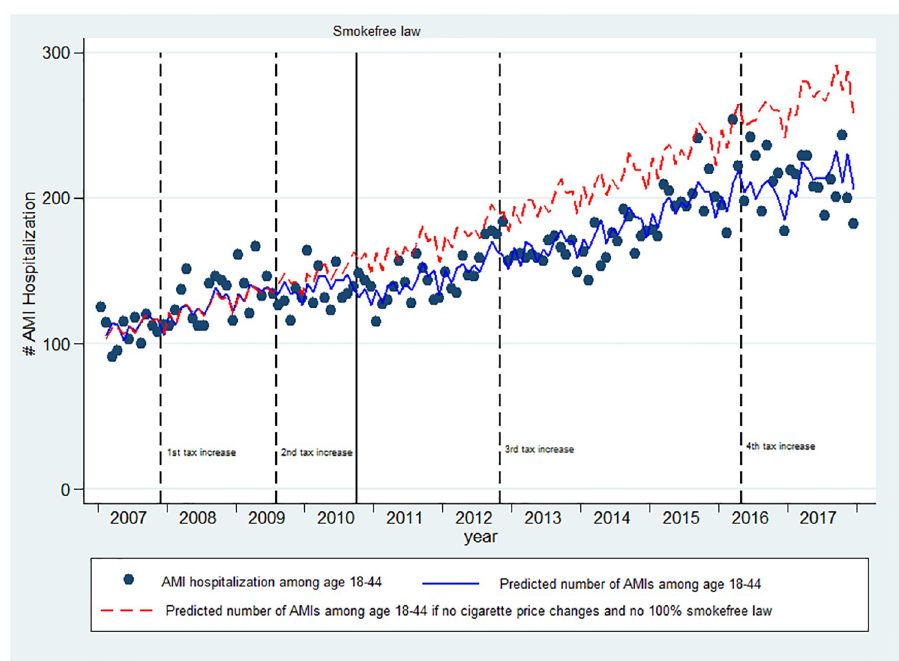
Fig 2. Association of increase in cigarette price and smokefree laws on AMI among young adults. The number of AMI hospitalizations among age 18–44 dropped significantly after the increase in cigarette price and the implementation of 100% smokefree law between October 2006 and September 2017. Solid lines (blue) on the plots are the predicted number of AMI hospitalizations per month from the negative binomial regression model. Dots are the number of AMI hospitalizations each month. Dashed lines (red) on the plots are the predicted numbers of AMI hospitalizations had there been no price changes and no 100% smokefree law. The ups and downs in the regression lines represent seasonal (monthly) variation in the number of AMI hospitalizations. Dash vertical lines indicate when the cigarette tax increased and a solid vertical line indicate when the 100% smokefree law was implemented.